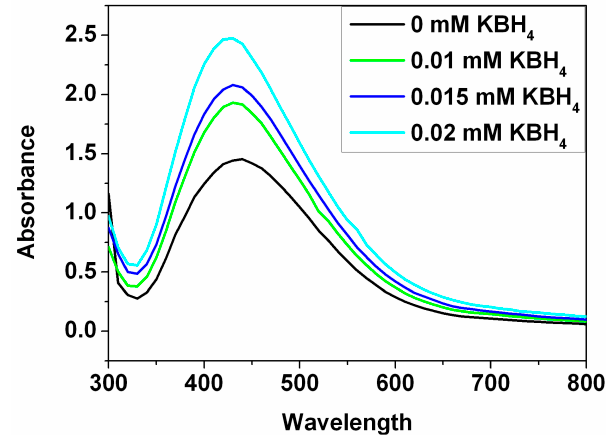
Figure 6. UV-Vis study of the Ag nanoparticle stability as a function of increasing KBH 4